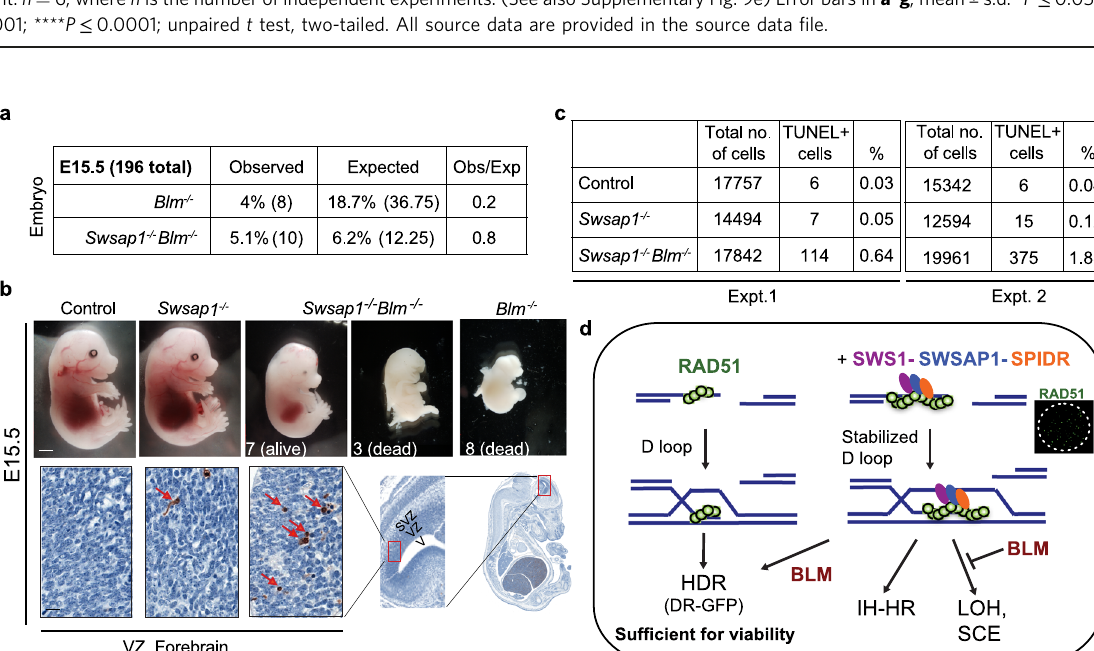
with the DR-GFP reporter or by gene